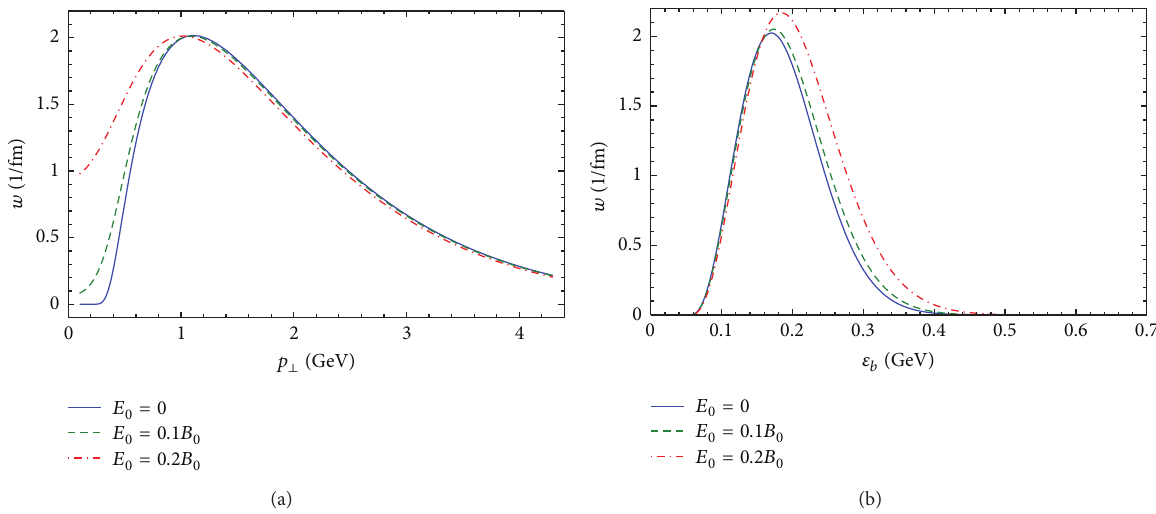
Figure 13: Dissociation rate of 𝐽/𝜓 at 𝑒𝐵 0 = 15𝑚 2 𝜋 , 𝜙 = 𝜋/2 (in the reaction plane), and 𝜂 = 0 (midrapidity) as a function of (a) 𝑃 ⊥ at = 0.16 GeV and (b) 𝜀 𝑃 = 1 𝜀 𝑏 𝑏 at ⊥